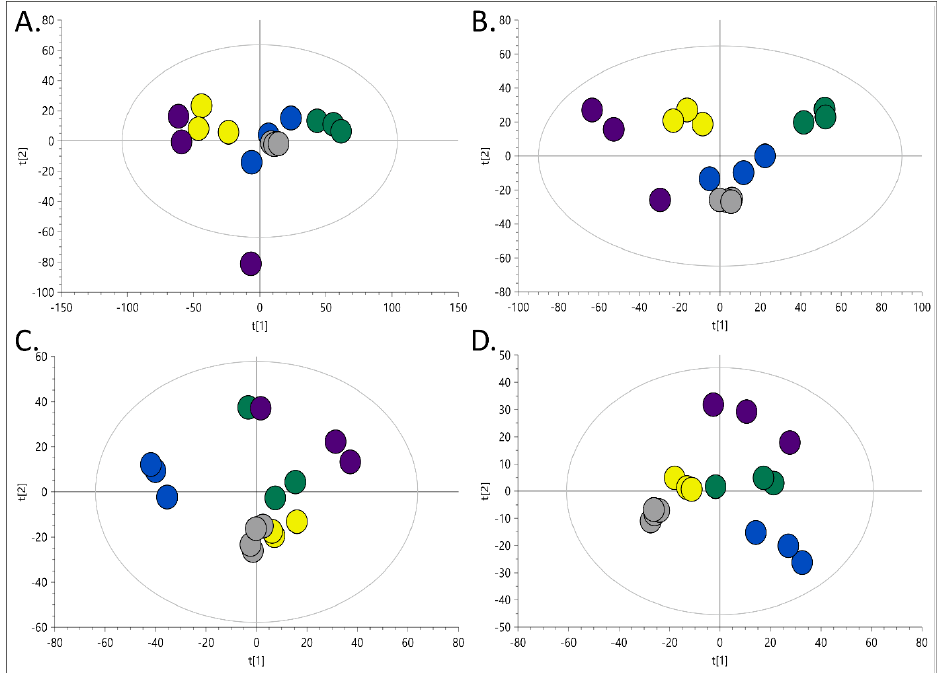
Figure 3. Multivariate PCA-X models built on data acquired during ( A ) RP-LC-MS (+), ( B ) RP-LC- model applied: blue—Method A, yellow—Method B, green—Method C, velvet—method D. The grey dots indicate several injections of the same sample—performed to evaluate apparatus-related variability.